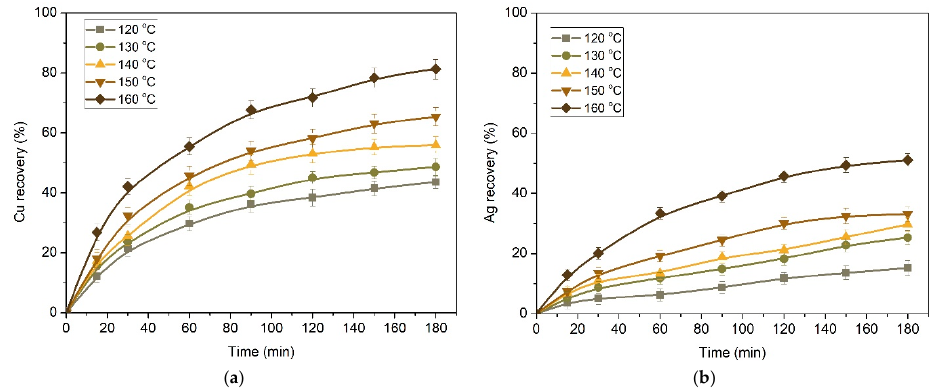
Figure 2. Effect of temperature and ammonia leaching duration on the degree of Cu ( a ) and Ag ( b ) recovery into solution. ( b ) recovery into